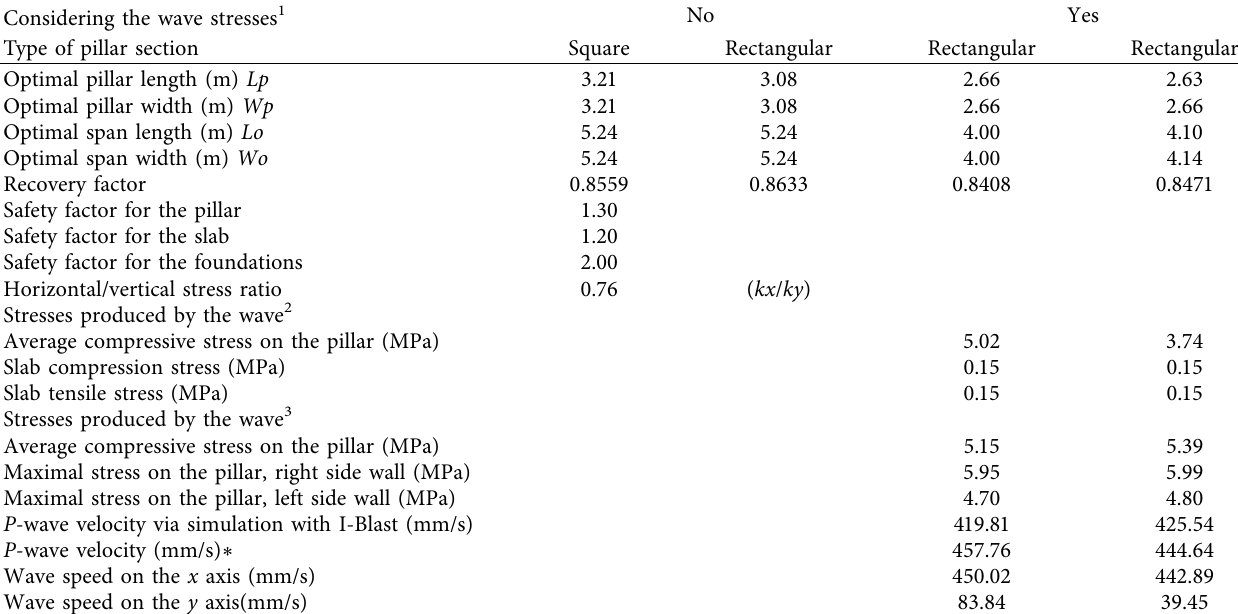
Table 5: Optimal sizing of rooms and pillars support when the wave affect is or is not considered. Considering the wave stresses 1 No Yes Type of pillar section